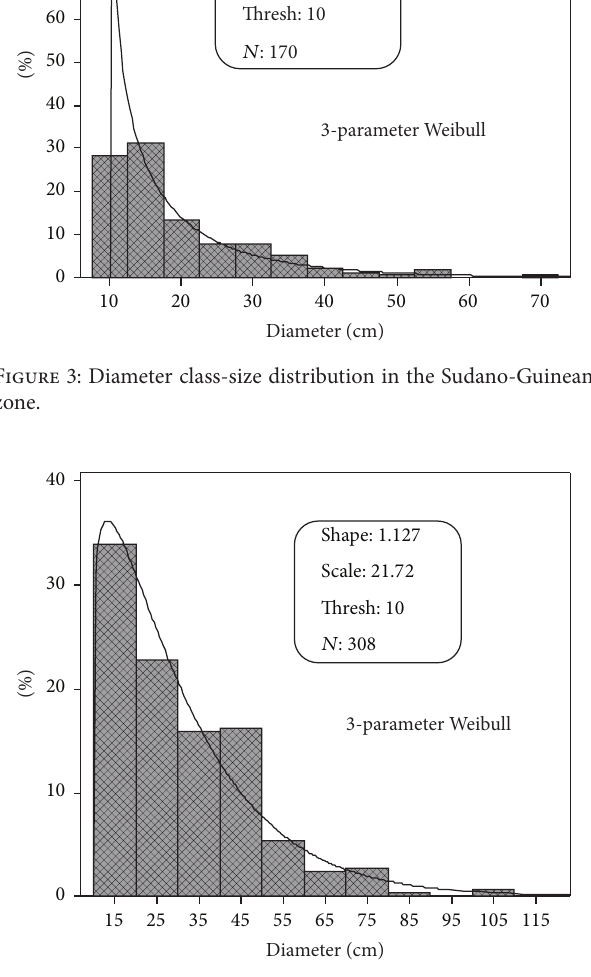
Figure 6: Height class-size distribution in the Sudano-Guinean